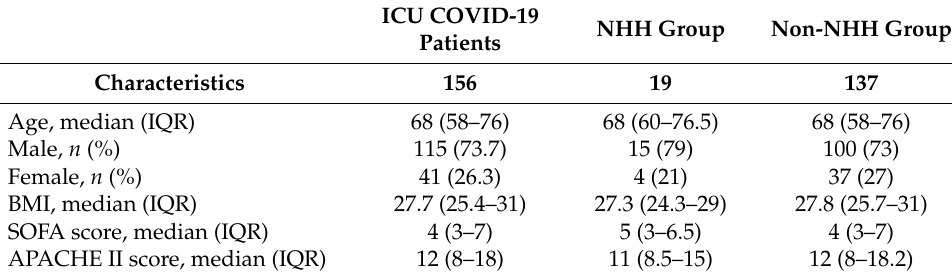
Table 1. The baseline characteristics of the ICU COVID-19 patients.